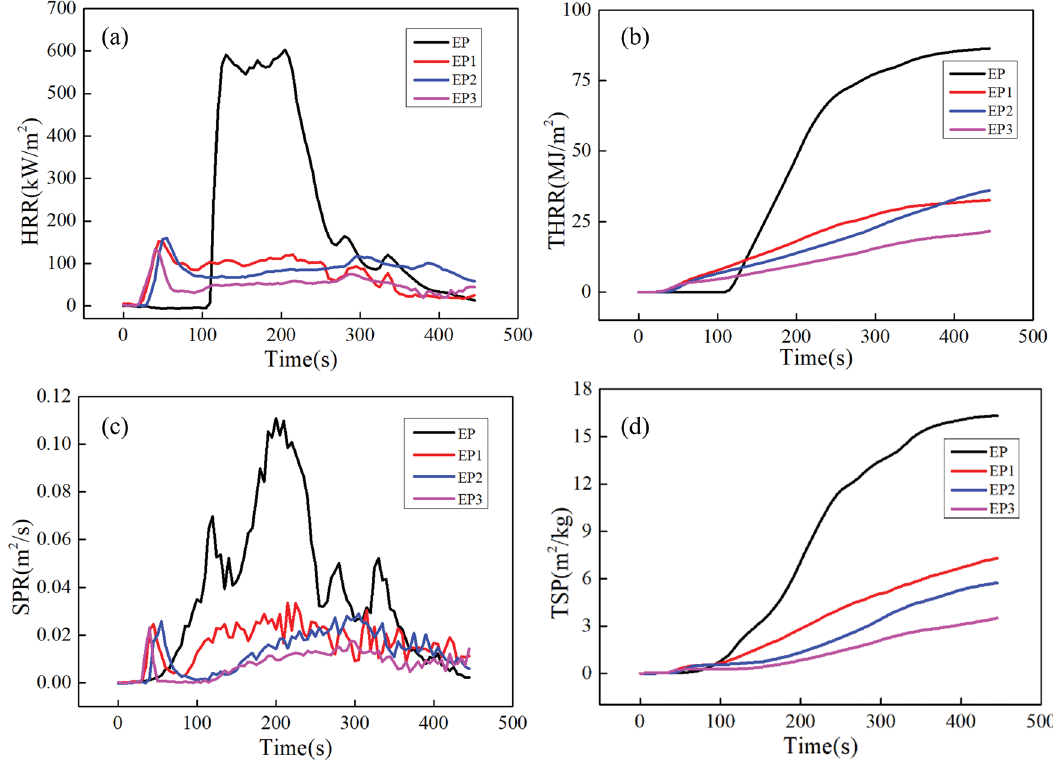
Figure 9: Cone calorimetry curves ( a: HRR, b: THR, c: SPR, and d: TSP )